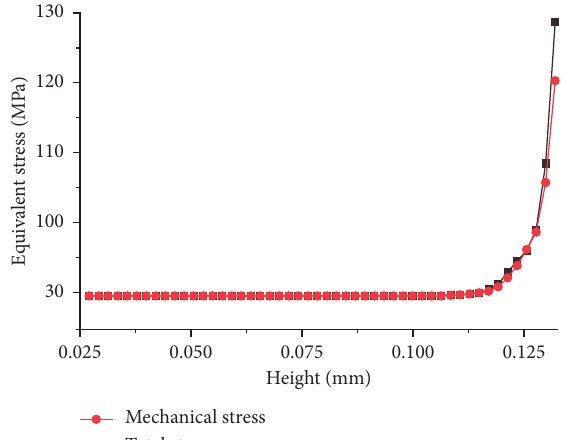
Figure 12: Equivalent stress distribution of the thermowell along the height direction under different loads in equilibrium state.